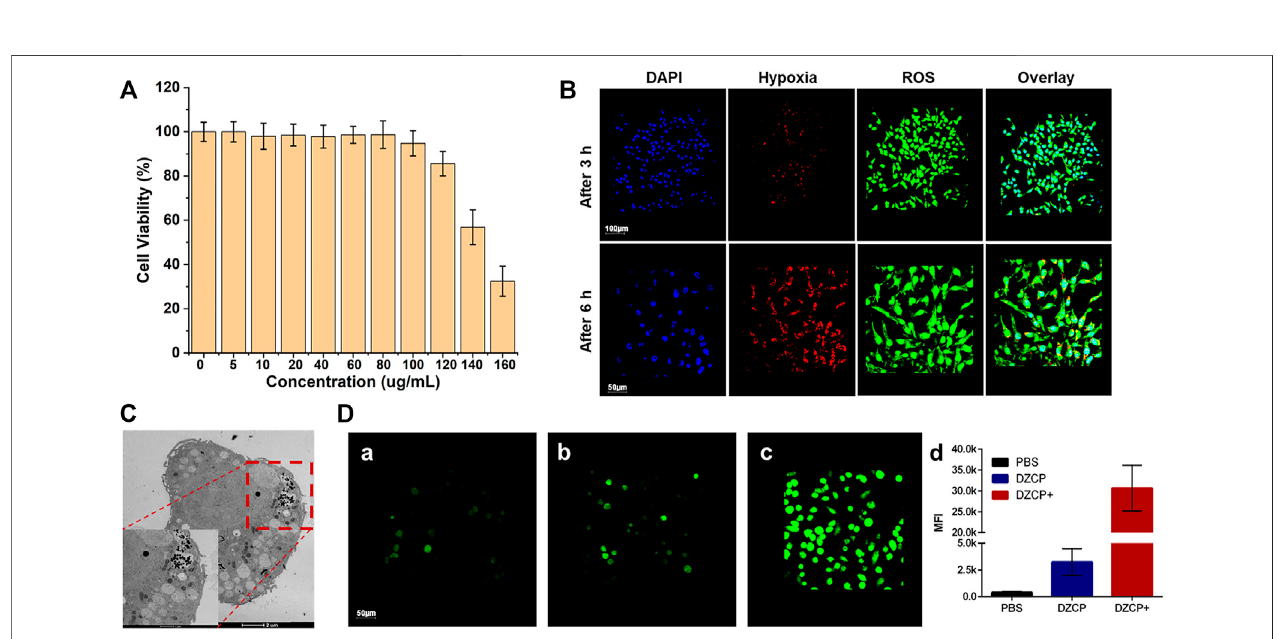
FIGURE 3 | (A) Relative viabilities of 4T1 cells treated with DZCP in the absence of ultrasonic waves for 24 h (B) ROS and hypoxia in vitro imaging of 4T1 cells. (C) TEM images of 4T1 cells after incubation with 160 μ g/ml DZCP after 24 h. (D) Green fl uorescence cell staining for ROS generation by 4T1 cells after treated with PBS, DZCP, or DZCP + under hypoxic conditions. The corresponding MFI values were analyzed and presented in (d). Green signals indicate the ROS generation.